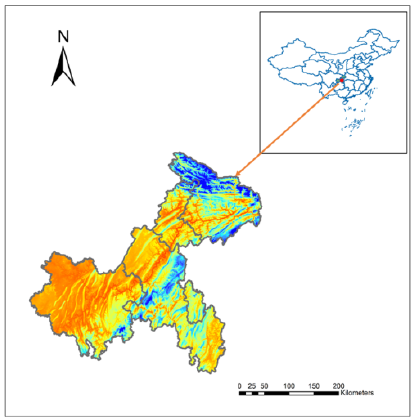
Figure 4. The geographical location of Chongqing.